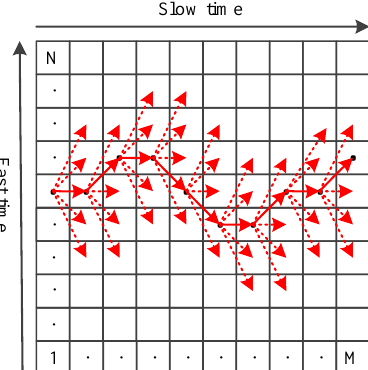
Figure 2. Take τ = 5 as an example to illustrate the envelope extraction using the HO-MF-TBD method. The dotted arrow represents the search range, and the solid arrow represents the points selected from the search range to estimate the